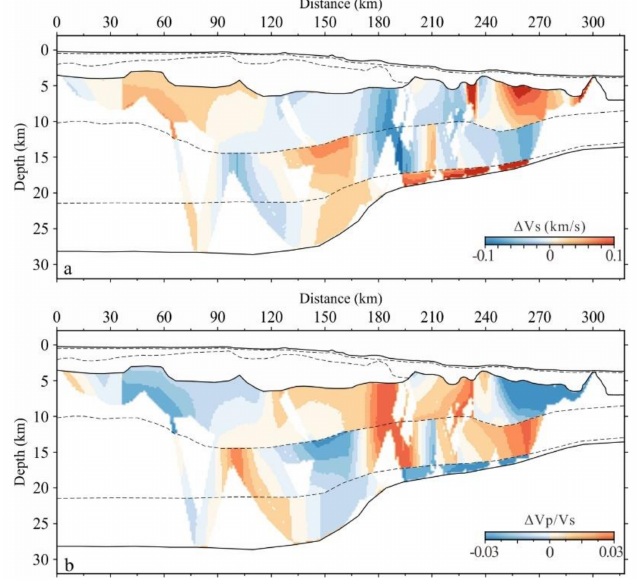
Figure 12. The difference between the forward and inversion results for crustal S-wave velocity ( a ), Vp/Vs ratios ( b ). ∆ Vs and ∆ Vp/Vs are the difference between inversion and forward results.